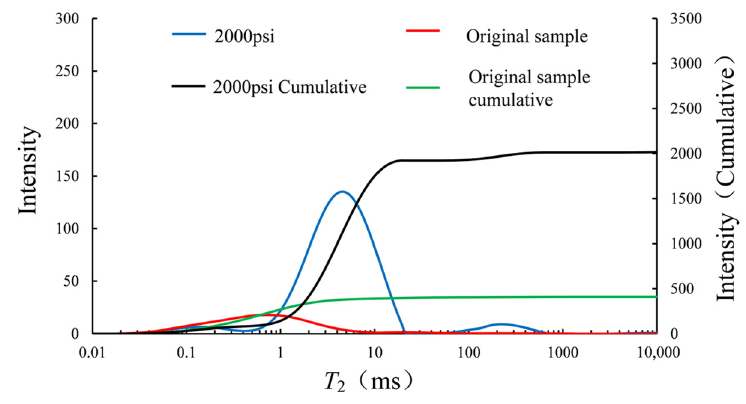
Figure 11. T 2 spectrums and cumulative curves of saturated oil experiments of inter-salt shale.